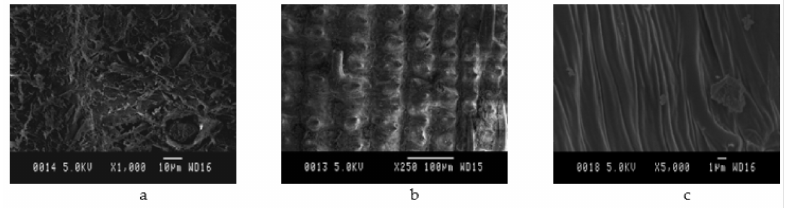
Figure 7. SEM microstructure of RHA [85]: ( a ) SEM of a chip from the RHA interlayer; ( b ) SEM of the outer surface of the RHA at 600 ◦ C; ( c ) SEM of the inner surface of the RHA at 600 ◦